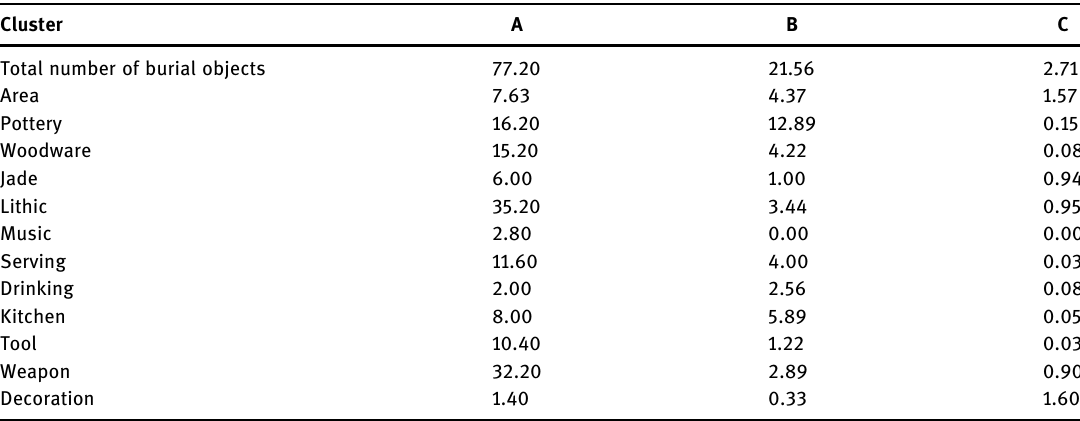
Table 4: Average values of selected burial variables in di ff erent groups Cluster A B